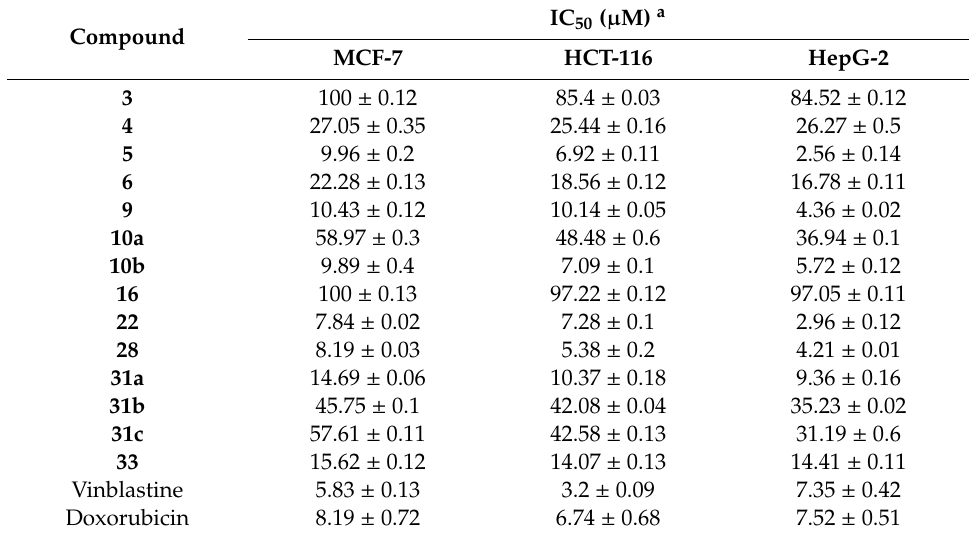
Figure 1. The IC 50 values expressed in ( µ M) of the target compounds against the MCF-7, HCT-116, and HepG-2 tumor cells. Table 1. The IC 50 values of the target compounds against the MCF-7, HCT-116, and HepG-2